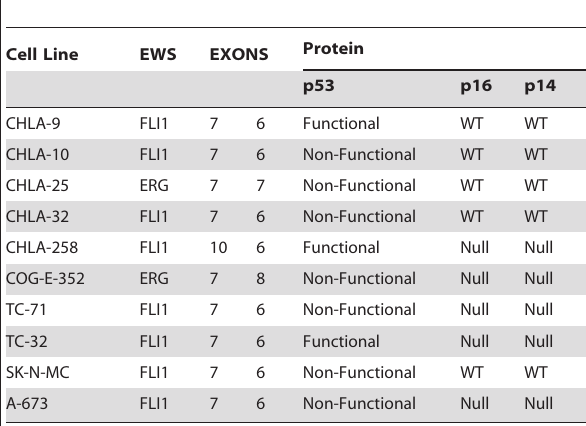
Table 4. The EWS/FLI1 or EWS/ERG breakpoints and p53 and p16/14 status of EFT cell